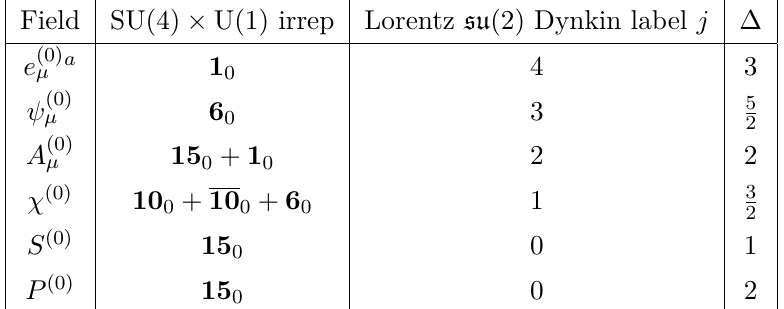
Table 3 . The KK spectrum for the level n = 0 of 11d supergravity on AdS 4 × S 7 / Z 4 with the periodic spin structure. The modes organize into the N = 6 energy momentum tensor multiplet of the dual